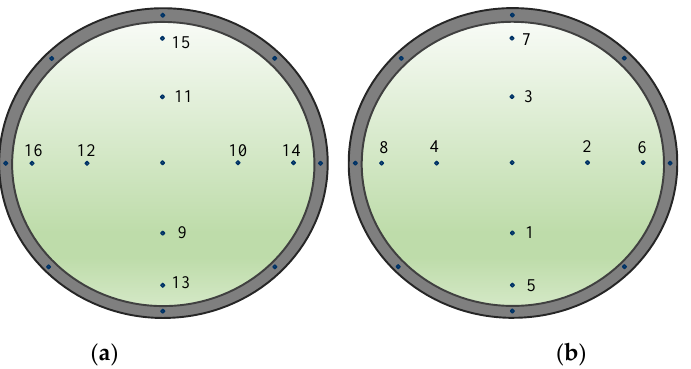
Figure 8. Schematic diagram of sampling-point numbering in the spherical chamber: ( a ) Bottom view of sampling points in the lower hemisphere; ( b ) top view of the sampling points in the upper hemisphere. Table 3. Dust-mass-concentration-distribution measurement results.